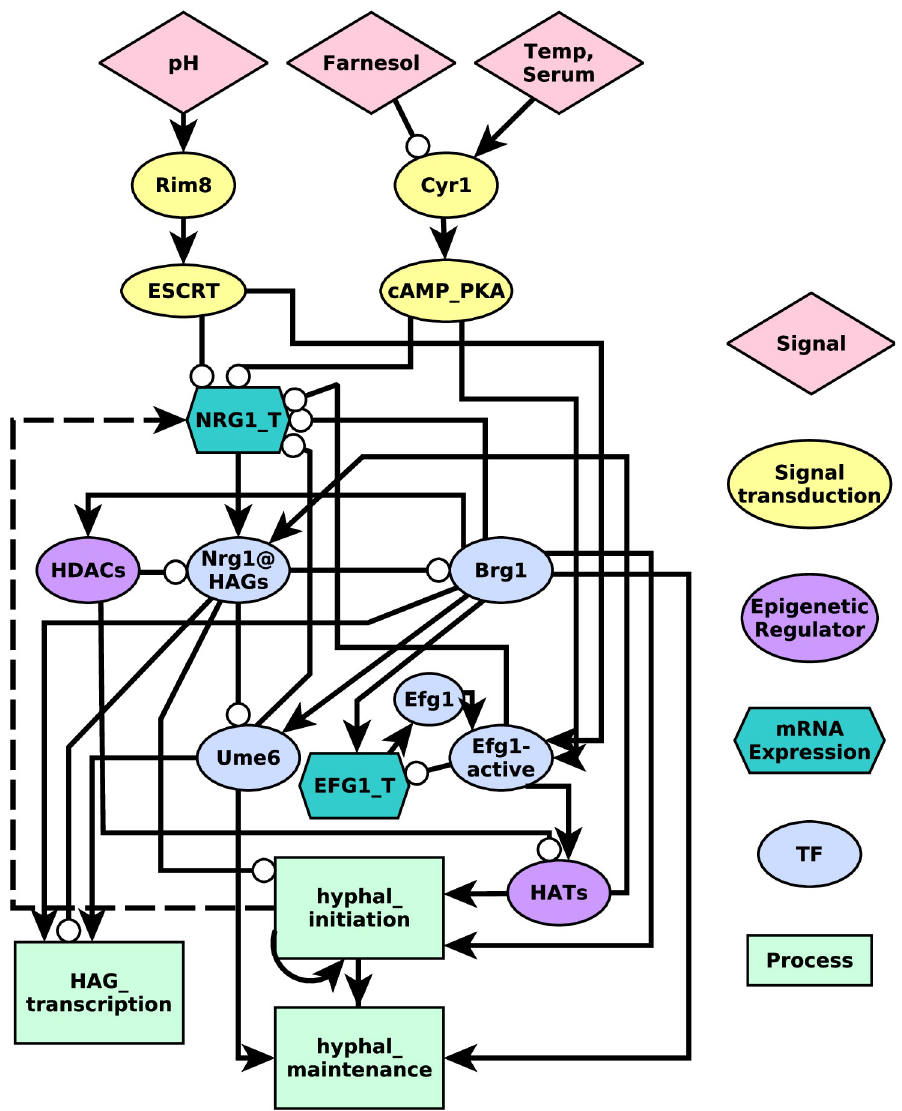
Fig 1. A regulatory network model of the yeast to hyphal transition induced by extracellular signals. The shapes and colors of the nodes indicate their function, as indicated in the key on the right. Dashed edges represent functional relationships whose molecular mechanisms have not been determined. We translate this network into a Boolean dynamic model by characterizing each node with a regulatory function (see Table